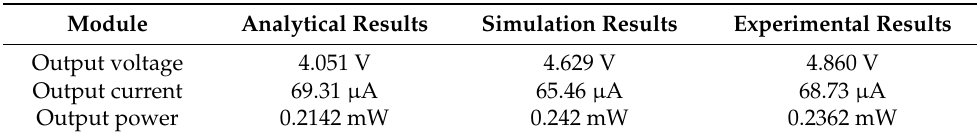
Table 3. Summarized results for Cockcroft-Walton voltage multiplier at 10